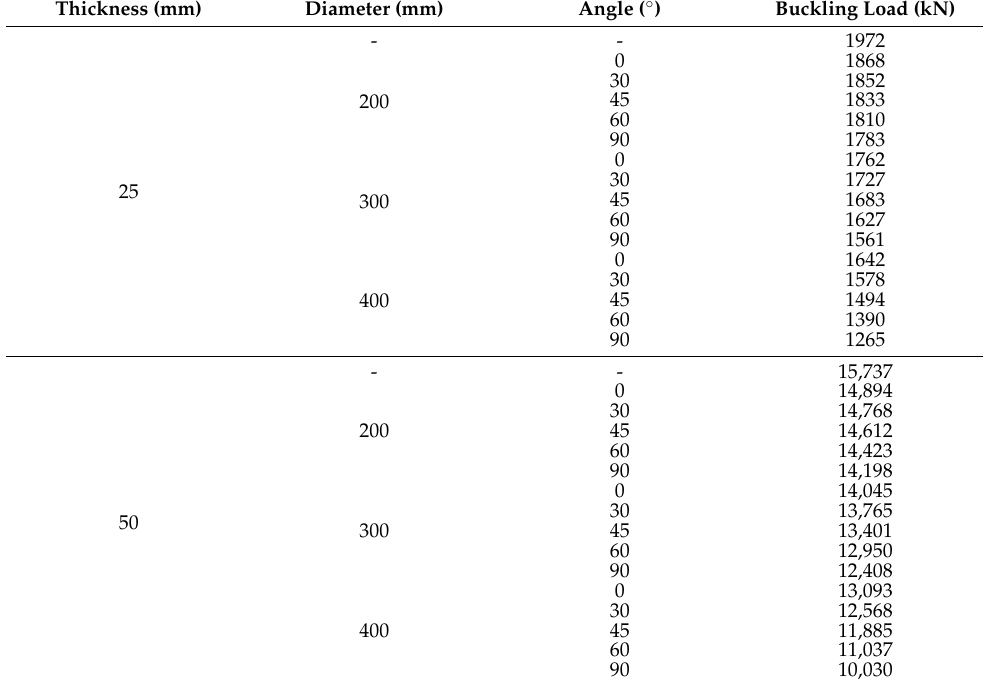
Table 2. The critical buckling load of the FGM plate with various cutout arrangements, plate thickness, and cutout